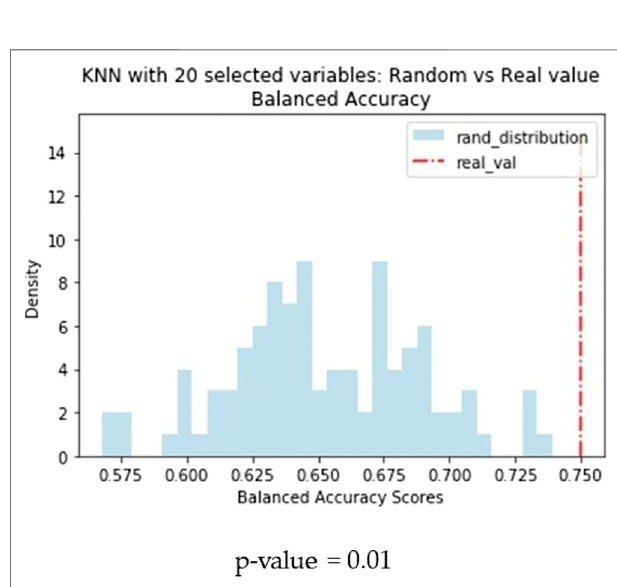
FIGURE 7 | Comparison of performance of the KNN models based on random subsets of features. Blue bars refer to the distribution of BA of models based on random subsets of 20 features, the red dashed line indicates the performance of the KNN model based on the 20 optimal features selected through the RF-based feature importance ranking.